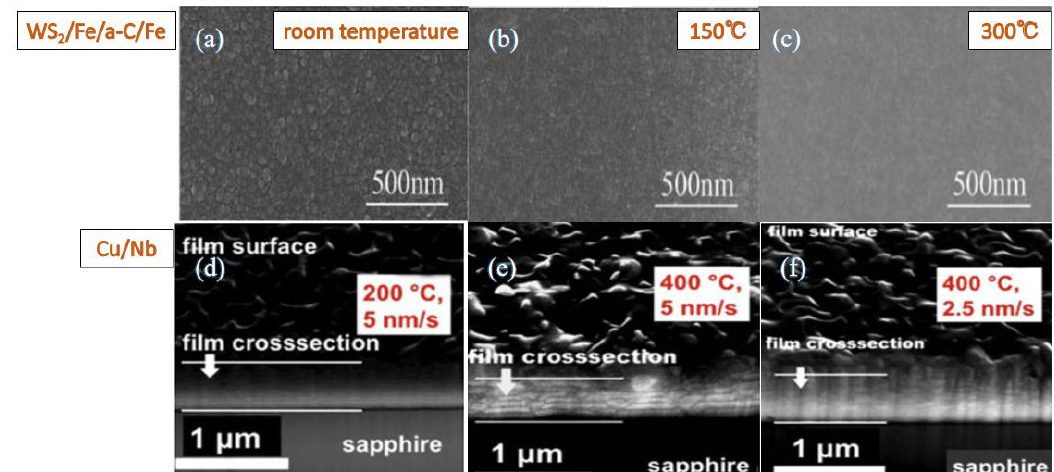
Figure 2. SEM micrographs of ( a – c ) WS 2 /Fe/a-C/Fe [22] and ( d – f ) Cu/Nb [2] multilayer films deposited at different temperatures. The morphology of multilayer films becomes smoother with rising deposition temperature. The cross- sectional images of Cu/Nb show the deterioration of layer continuities with an increasing substrate temperature and decreasing deposition rate. Reprinted with permission from [22] Elsevier 2020, [2] Elsevier 2011.